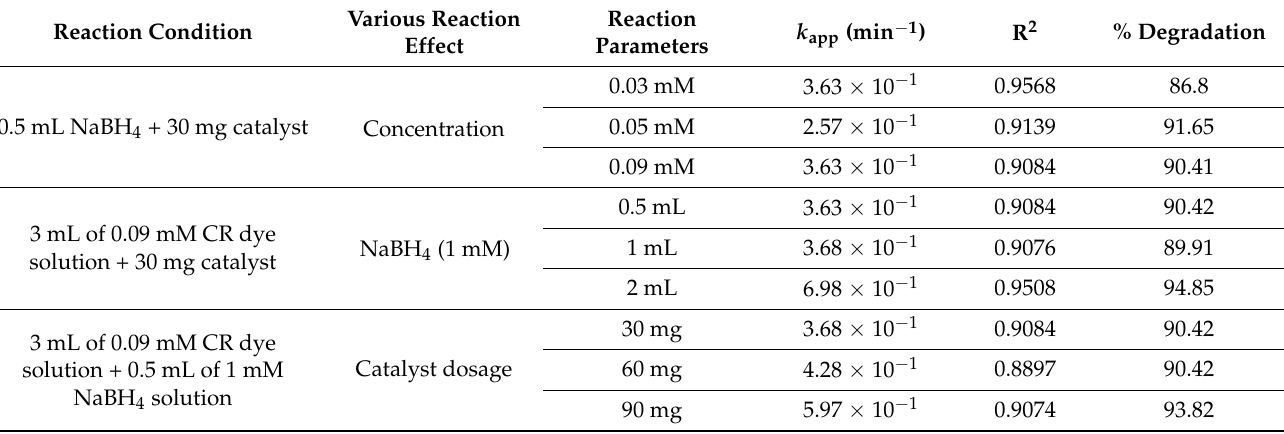
Table 3. Effect of concentration, catalyst dosage, and reducing agent on the discoloration of CR dye using Alg-CoNi2/FP@Co NPs as a dip